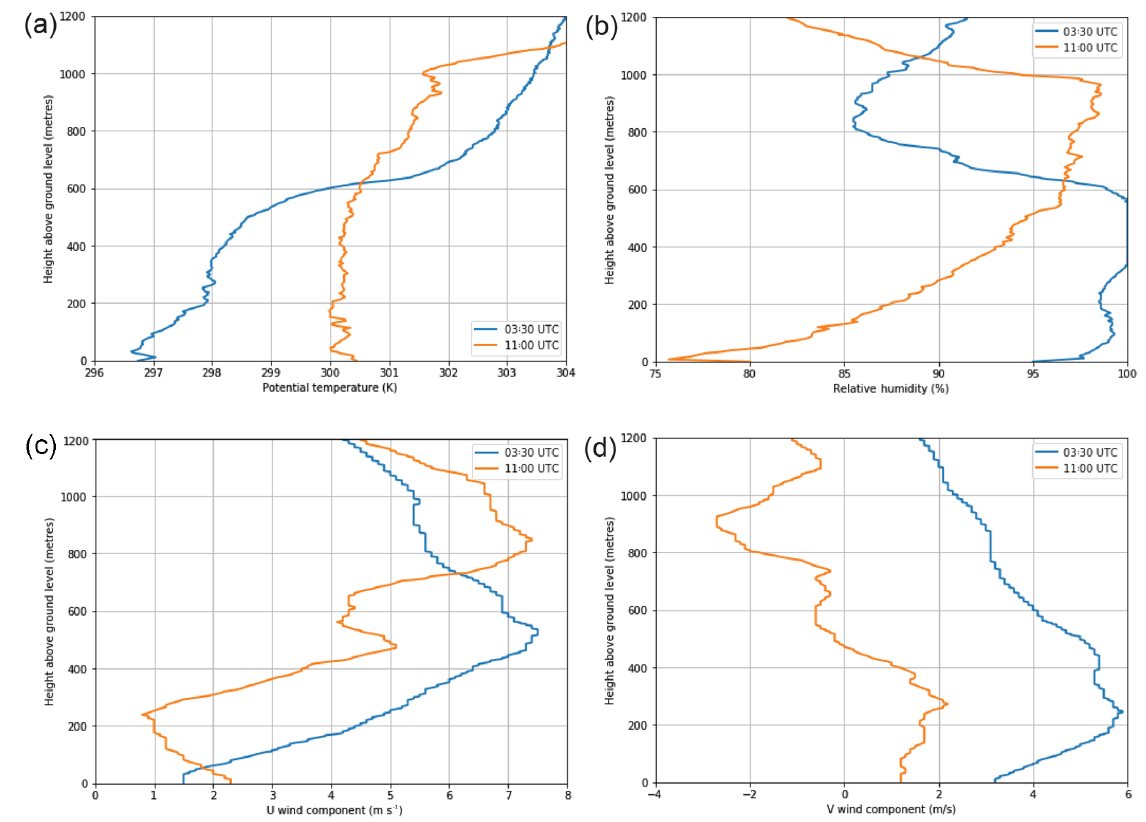
Figure 2. Profiles of (a) potential temperature, (b) relative humidity, (c) the u wind component, and (d) the v wind component from ra- diosondes launched at Savé on 5 July 2016 at 03:30UTC (blue) and 11:00UTC